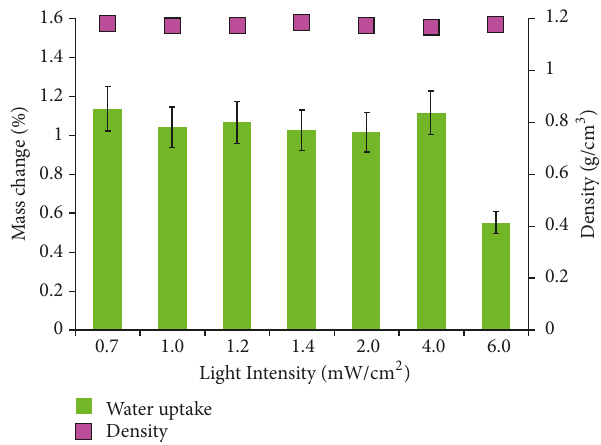
Figure 7: Densities and water uptake of the photocured resins irradiated at different intensities after an irradiation time of 30 seconds.